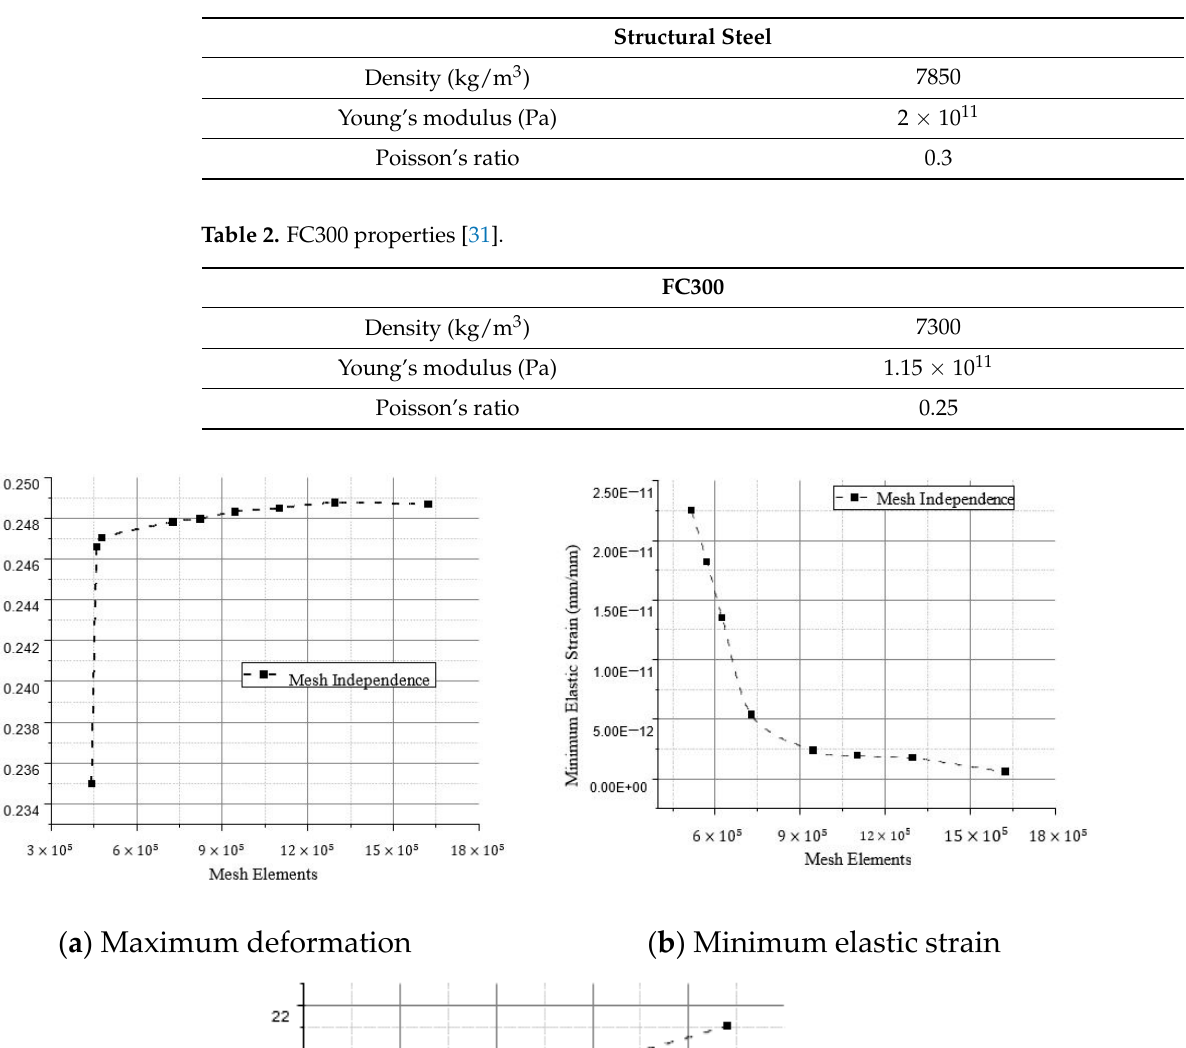
Table 2. FC300 properties [31]. variation in deformation of all variables stabilized after the eighth point. Therefore, for this investigation, the converged mesh number was defined as elements. Table 1. Structural steel properties [30].